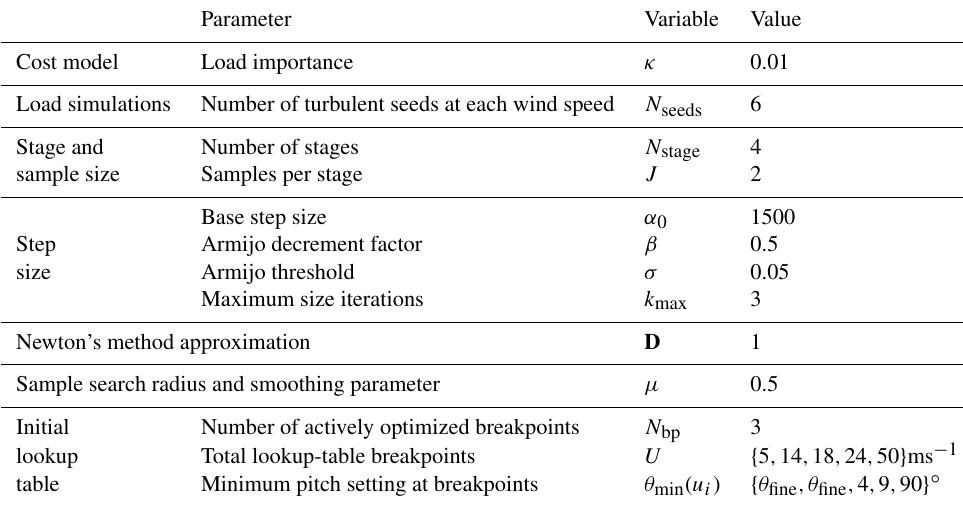
Minimum pitch setting at breakpoints θ min ( u i ) { θ fine ,θ fine , 4 , 9 , 90 }